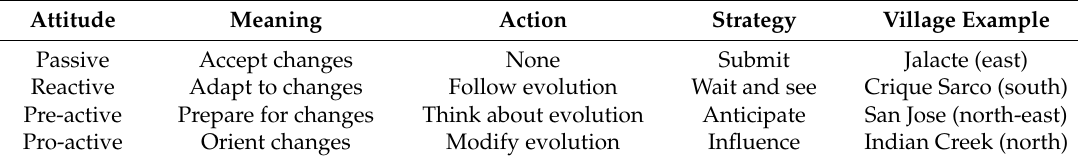
Table 4. Farmer attitudes and responses in the face of changes in southern Belize ( italics from [76]). See Figure 1 for location of